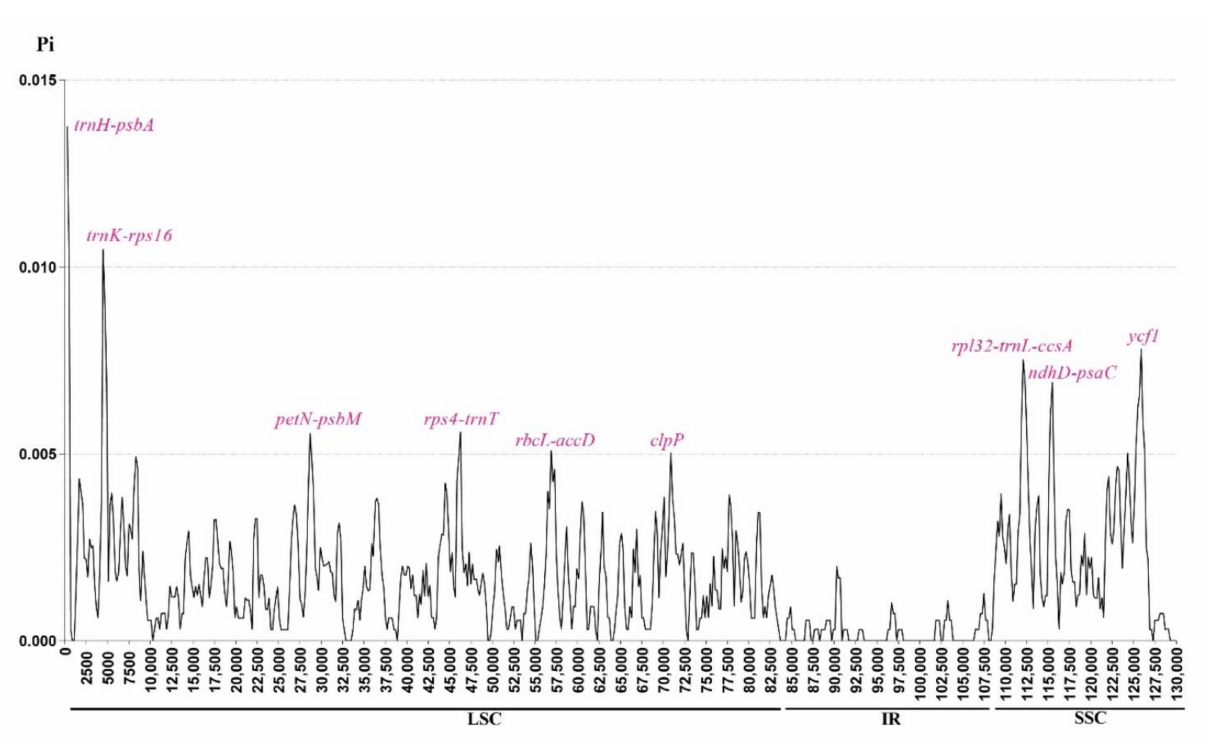
Figure 8. Sliding window analysis of plastomes of 10 taxa of Salvia sect. Drymosphace . The X -axis indicates the position of the midpoint of a window, and the Y -axis represents the nucleotide diversity of each window. The nine hyper-variable regions with Pi > 0.005 are